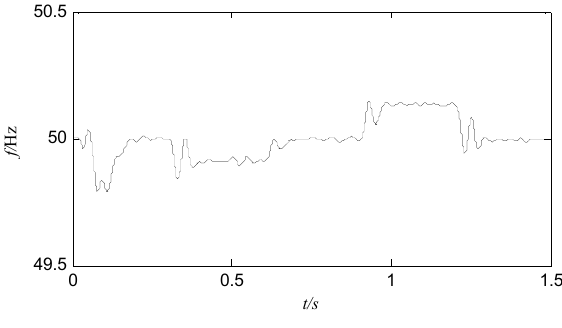
Figure 17. The frequency response of micro ‐ grid.